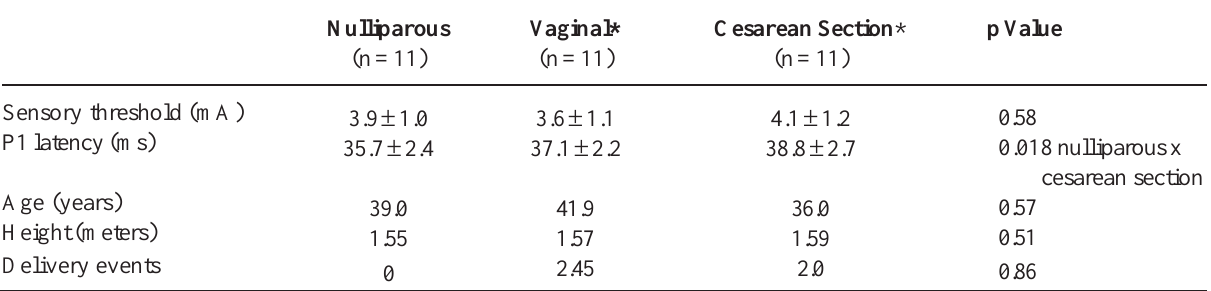
Table 3 – Results of clitoral sensory threshold and pudendal somatosensory evoked potential latency according to pregnancies and